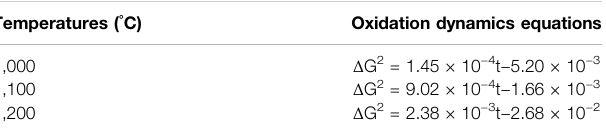
TABLE 3 | Oxidation kinetic equation of Co-20Re-25Cr-3Si alloy at 1,000 – 1,200 ° C. Temperatures ( ° C)